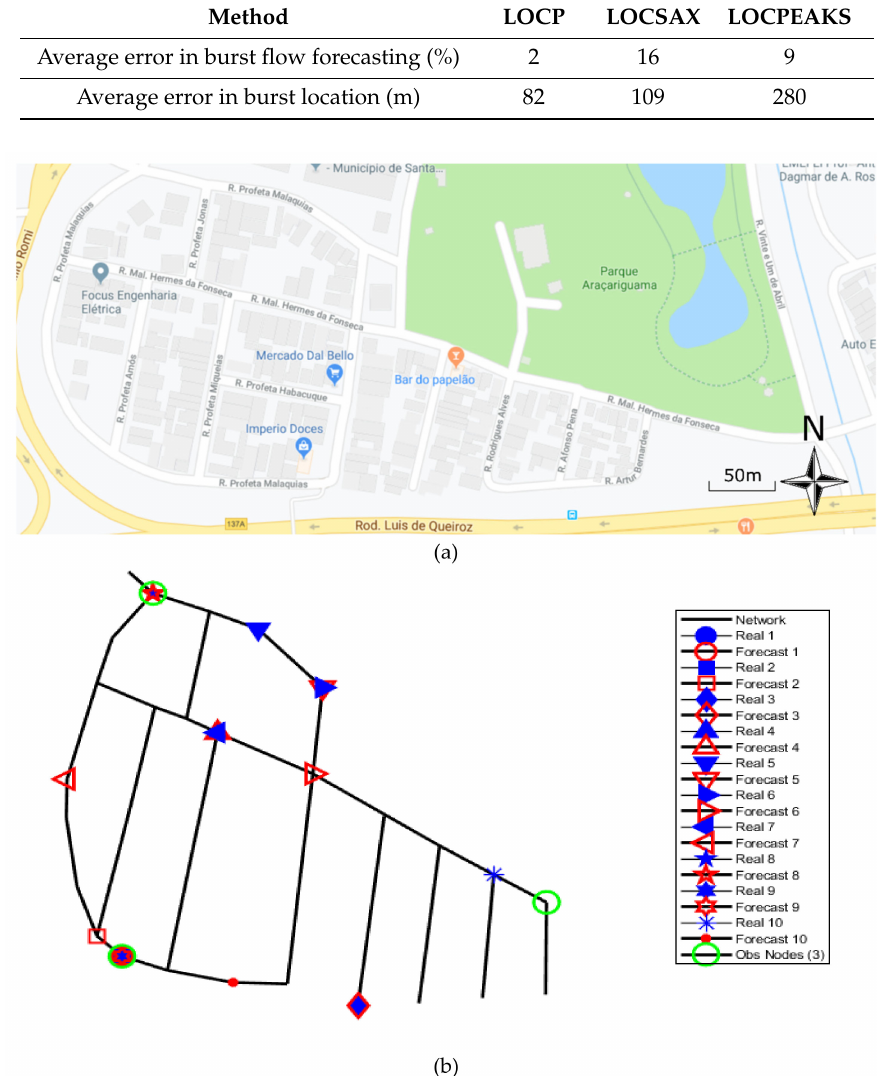
Figure 5. ( a ) Scale map of the district metered area (DMA) Laudissi: adapted from Google Maps ( b ) Results for test scenarios using LOCP method in Jardim Laudissi